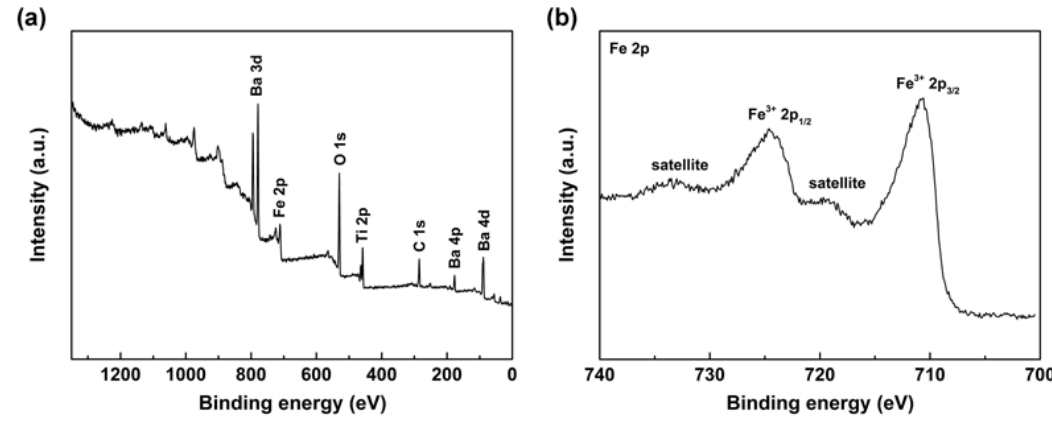
Figure 3. X-ray photoelectron spectroscopy (XPS) spectra of Fe 2 O 3 @BT nanoparticles: ( a ) survey scan, ( b ) Fe 2p.